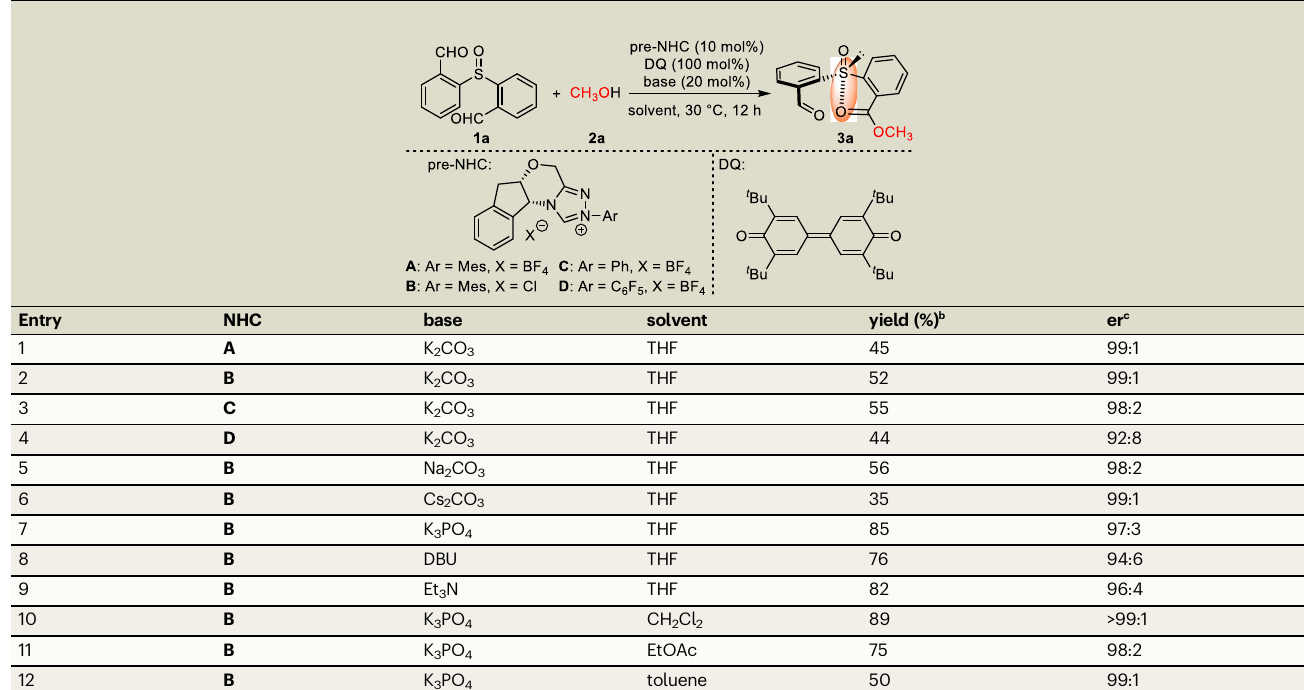
Table 1 | Optimization of reaction conditions